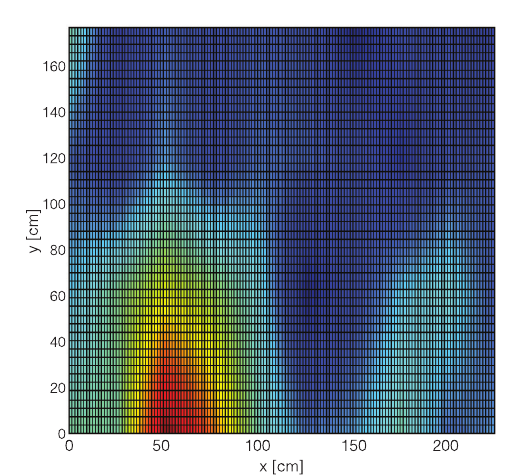
Fig. 16. Horizontal slice at 15 ns outside the theatre area (square